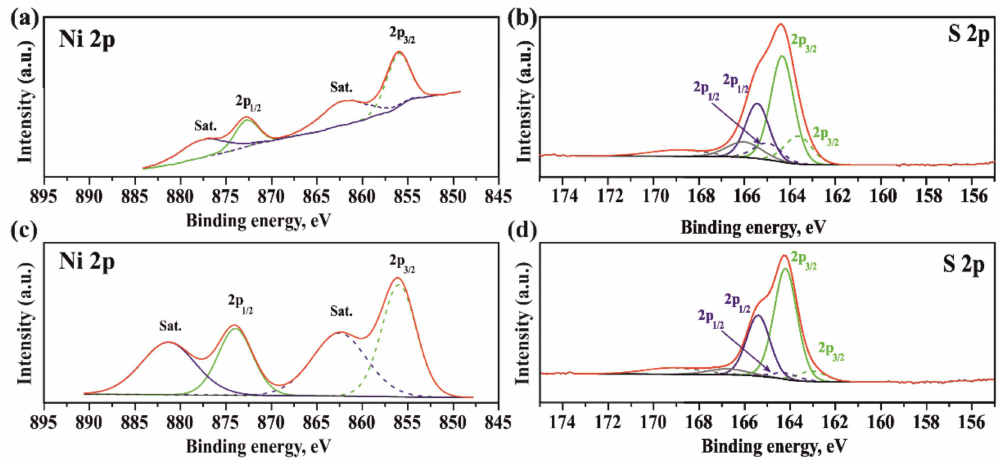
Figure 6. XPS spectra of coke-containing catalyst after CA ( a , b ) and CA+T ( c , d ).